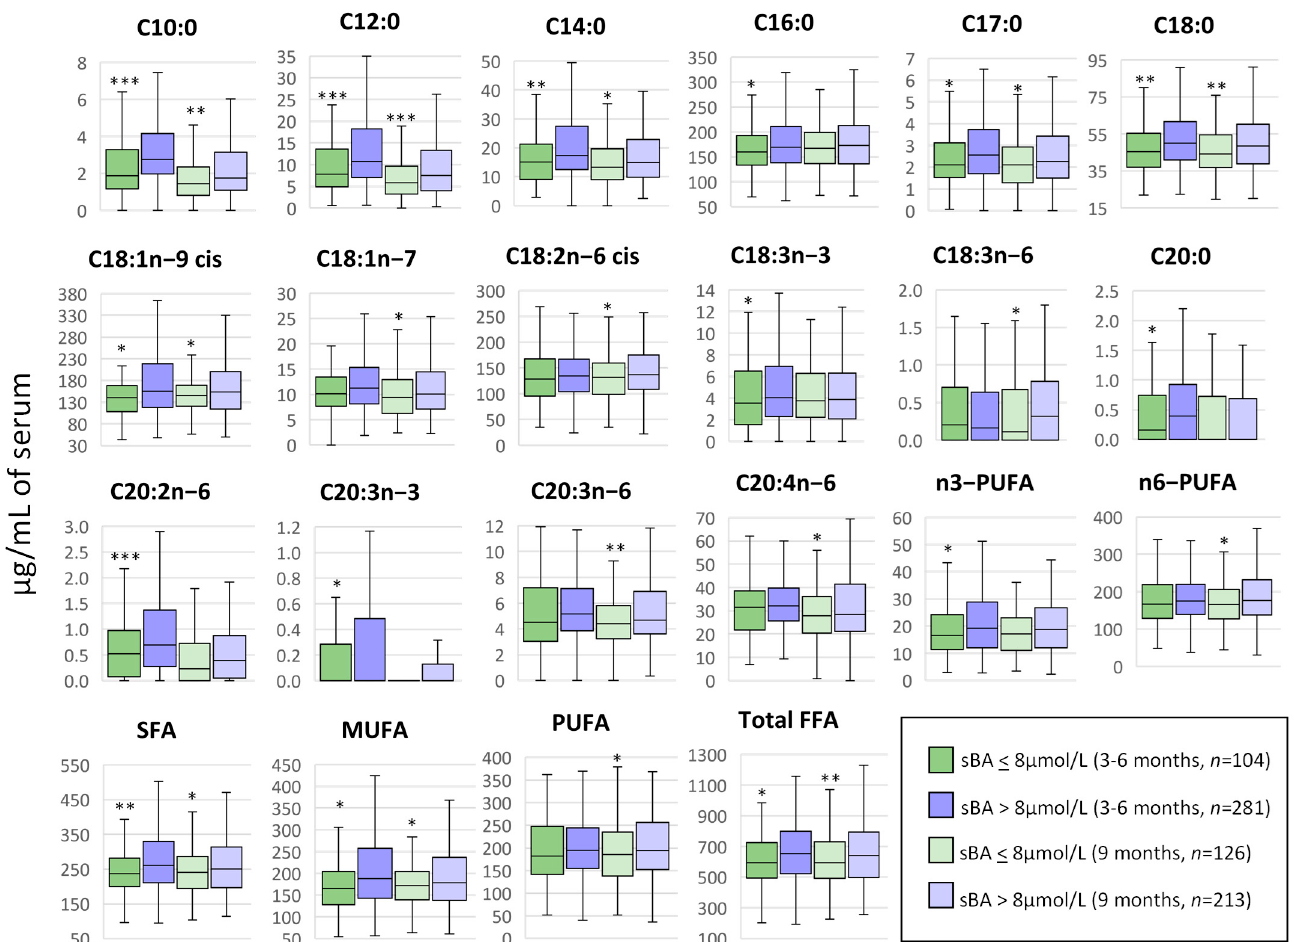
Figure 7. Correlation between serum NEFA and bile acids in Pakistani children at 3–6 months and 9 months of age. At both time points, concentrations of serum NEFAs ( µ g/mL) were correlated with total serum bile acid (sBA) concentration ( µ mol/L) by using a t-test, where the grouping criteria considered were sBA < 8 µ mol/L (normal concentration) and sBA > 8 µ mol/L (liver dysfunction and/or cholestasis). Median values and interquartile ranges are shown in boxplots. * p <